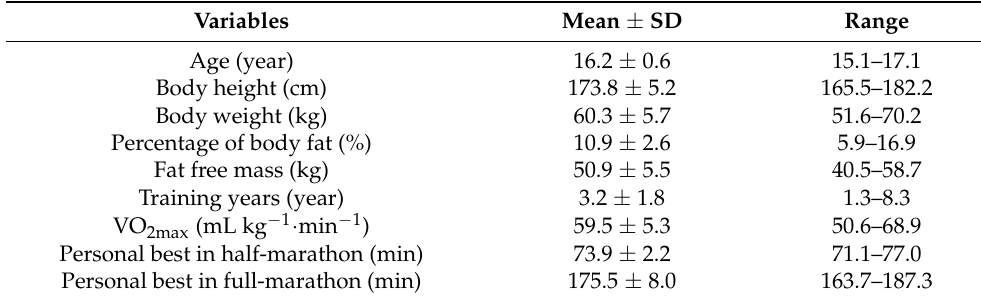
Table 1. Subjects’ physical characteristics, training years and personal best in marathon race are shown ( n =